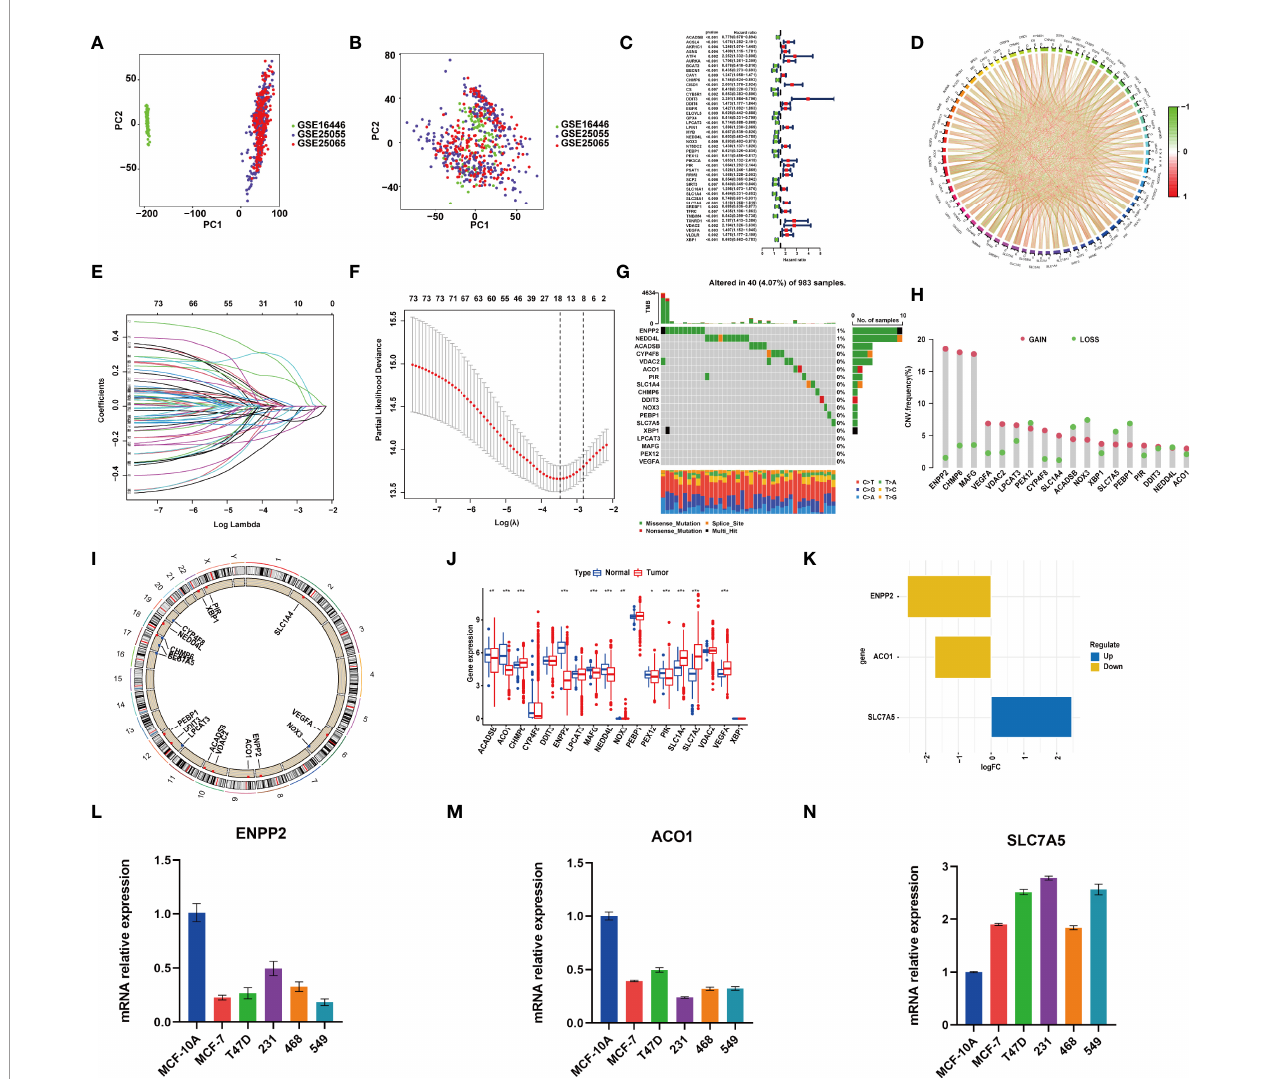
FIGURE 1 | RNA-sequencing (RNA-Seq) data of training and test cohorts before (A) and after (B) removing batch effects. (C) The hazard ratio (HR) and p-value of selected ferroptosis-related genes (FRGs) using the univariable Cox HR regression (criteria: p-value <0.01). (D) Expression interaction of the 76 FRGs in BRCA. The lines connecting the FRGs show how they are correlated with each other, with positive associations in red and negative associations in green. (E) The least absolute shrinkage and selection operator (LASSO) Cox analysis identi fi ed 18 FRGs most related to prognostics. (F) The 10-round cross-validation determined the optimal values of the penalty parameter. (G) In all, 40 of 983 (4.07%) BRCA patients experienced 18 FRG genetic alterations. (H) Copy number variation (CNV) mutation frequency of the 18 FRGs. This column represents the frequency of change. Deletion frequency is represented by green dots, while ampli fi cation frequency is represented by pink dots. (I) The location of the 18 FRGs in chromosomes. Blue point represents the genes that mainly had CNV deletion; red point represents the genes that mainly had CNV ampli fi cation. (J) Expression of the 18 FRGs in normal tissues and BRCA tissues. Genes with red color represent the differentially expressed genes. (K) The value of logFC of the 18 FRG genes. (L – N) qRT-PCR results showed the expression value of the three FRGs in the normal breast and fi ve breast cancer cell lines. *, P < 0.05; **, P < 0.01; ***, P <